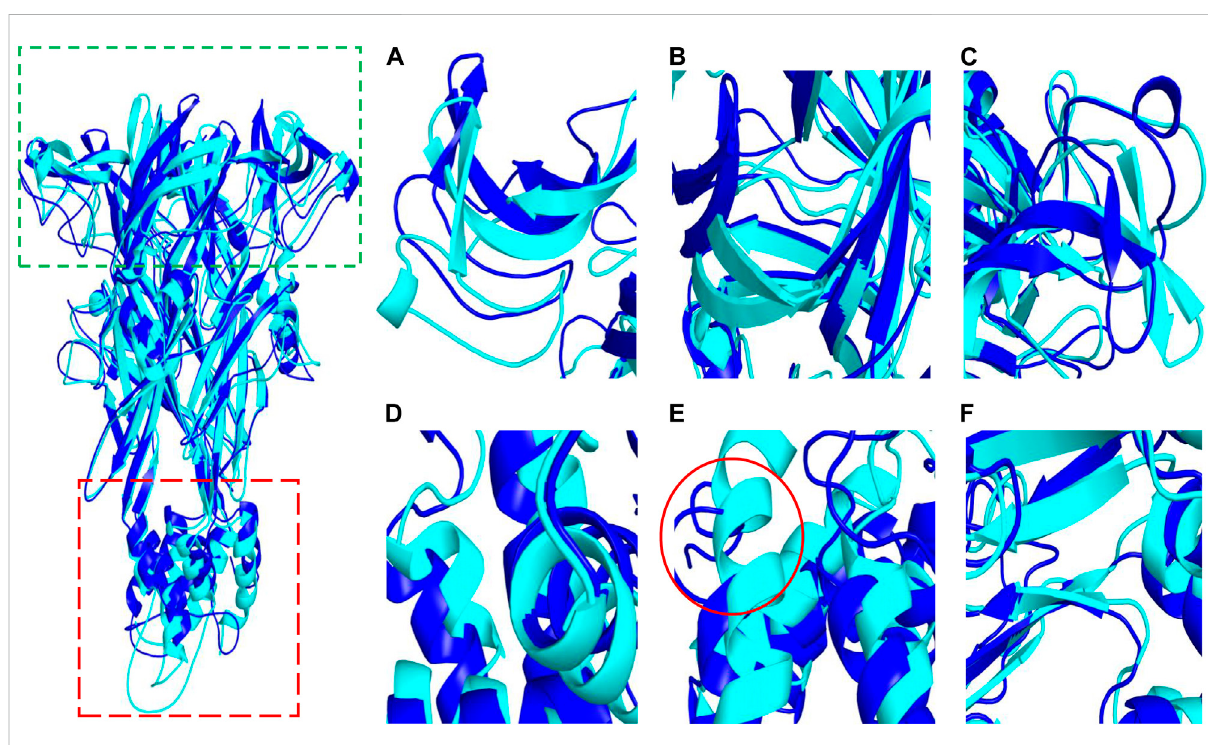
FIGURE. 9 TheconformationaldifferencebetweenP2X7RandP2X7R-ligand.Thediagramontheleftshowsconformationaldifferencesbetweenthepure protein (P2X7R, blue) and the protein ‒ ligand (Z1456467176, cyan). The green and red boxes indicate the approximate locations of the domains shown in (A – C) and (D – F) , respectively. (A – C) The conformation of the open region at the upper end of P2X7R. (D – F) The conformation of the helical region of